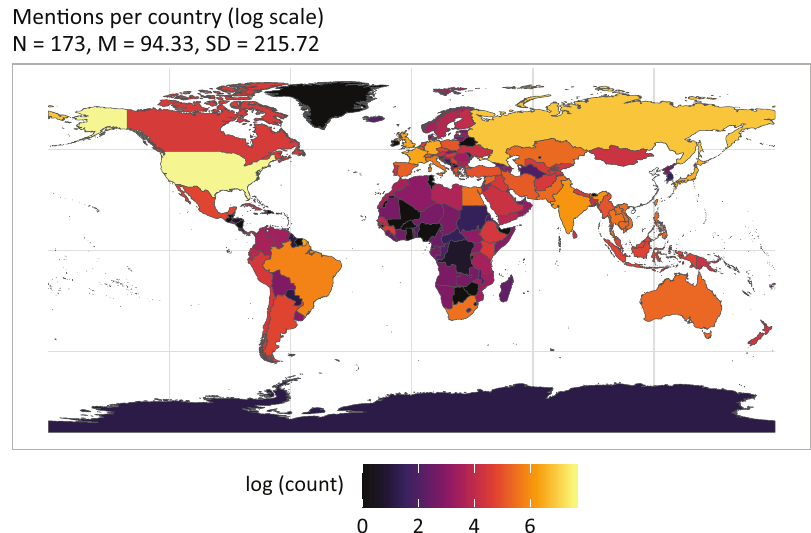
Figure 8. People’s Daily mentions by country. Notes: Mentions are shown at the country level. The source of this spatial data, Natural Earth, lists all dependent territories separately. Because the count data is highly variable, a natural log scale was used.